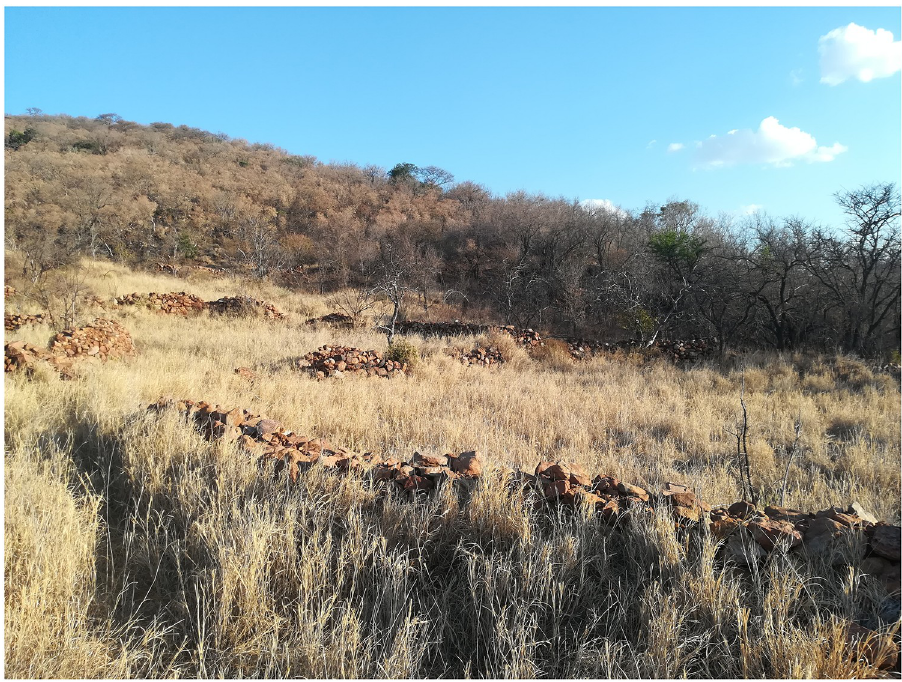
Fig 3. View of the site of Seoke, October 2019 Stone Walls at Seoke, southern cluster. Cenchrus ciliaris (buffalo grass) can reach 1,5 meters in height.